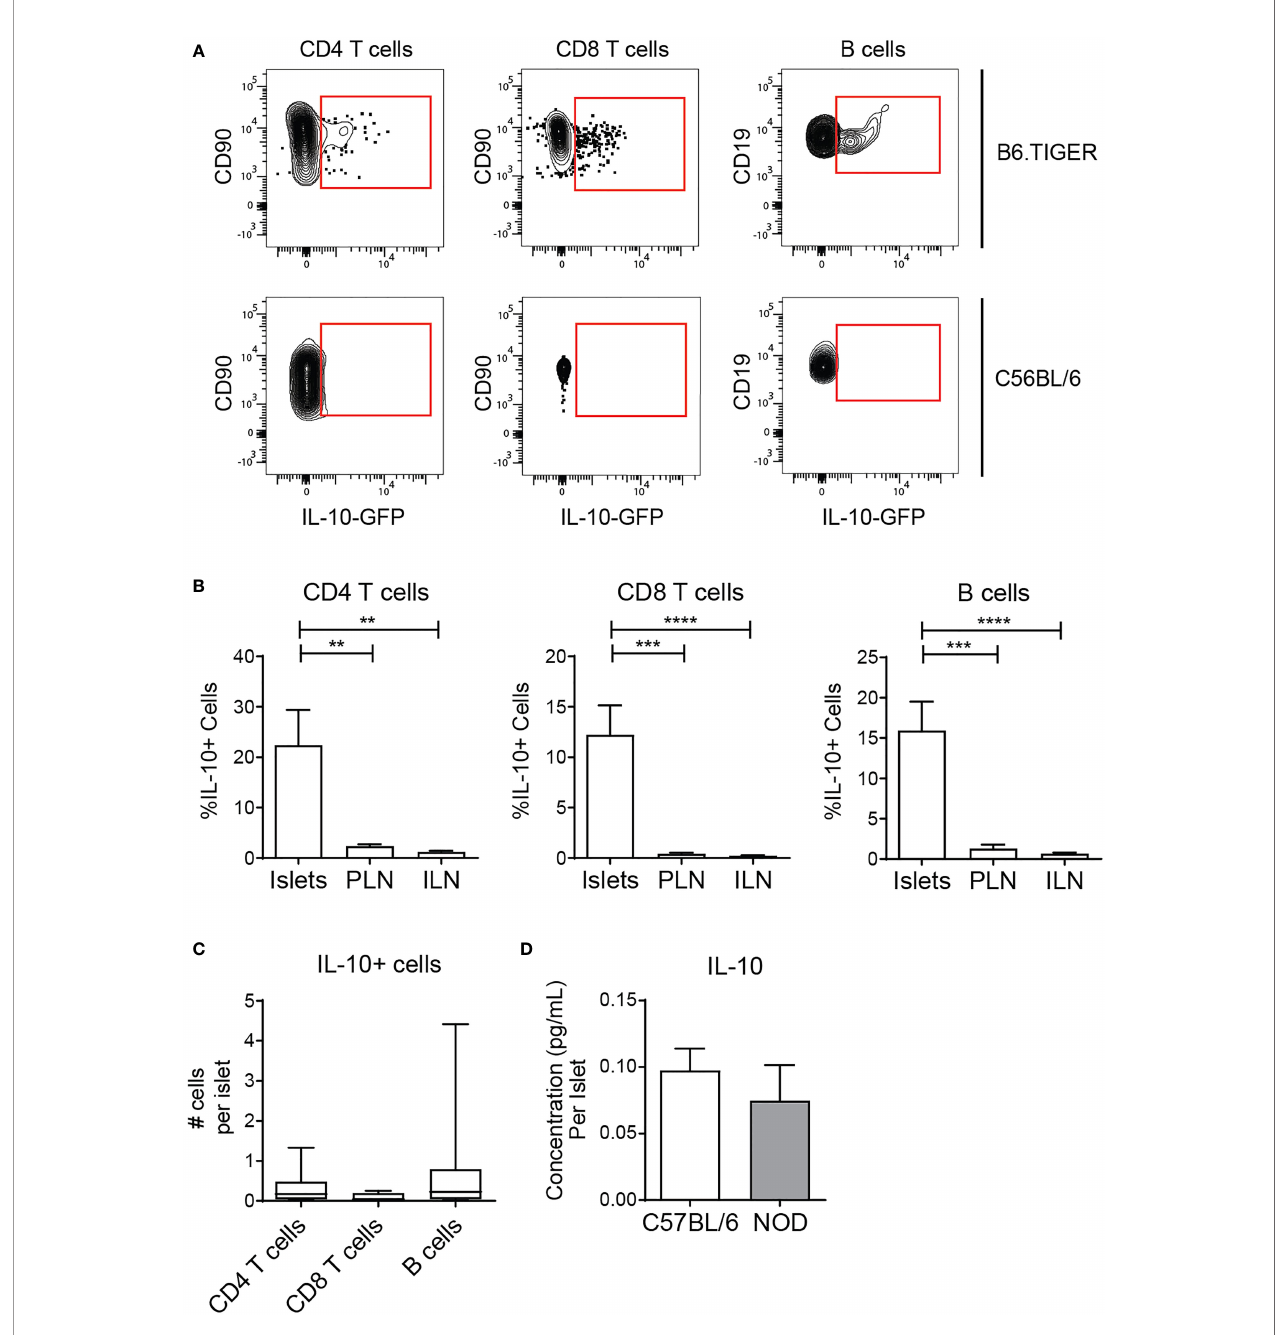
FIGURE 6 | Islet T cells and B cells express the anti-in fl ammatory cytokine IL-10. (A, B) Flow cytometry analysis of IL-10 expression in TIGER IL-10-GFP reporter mice. n=12 mice from 3 independent experiments. (A) Representative IL-10-GFP expression in islets. (B) Percent IL-10-GFP reporter positive CD4 T cells, CD8 T cells, and B cells. (C) Number IL-10-GFP+ CD4 T cells, CD8 T cells, and B cells per islet. (D) Secreted IL-10 protein from whole islet cultures. (B – D) n=7 C57BL/6 mice, n=6 NOD mice from 3 independent experiments. Statistics: **p < 0.01, ***p < 0.001, ****p < 0.0001. Error bars: SEM. (B, C) One way ANOVA with Bonferroni post-test. (D) Mann Whitney two-tailed